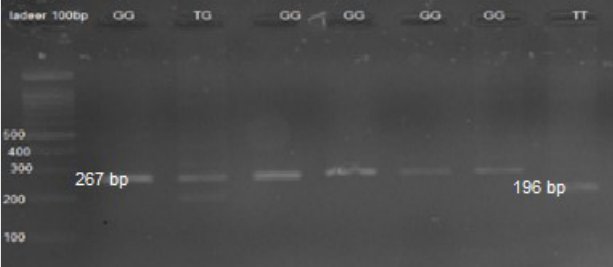
Fig. 1. RFLP results of rs13181 polymorphism of ERCC2 gene. The presence of two 70 and 196 bands represents TT genotype, the presence of triple bands of 196, 267, and 70 represent TG genotype, and the presence of a 267 bp band represents GG genotype, which in turn represent homozygous, mutant, homozygote, heterozygote, and Wild- type